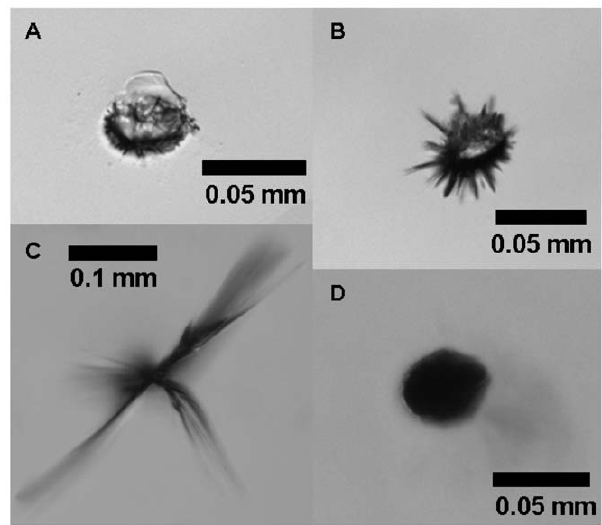
Figure 3. Microscope magnifications of several laser induced damaged areas in the IOLs from figure 2. a) area 3 in figure 2a; b) area 5 in figure 2a; c) area 1 in figure 2b; d) area 4 in figure 2b. Laser- induced damage was scored as mild damage except for c) which was